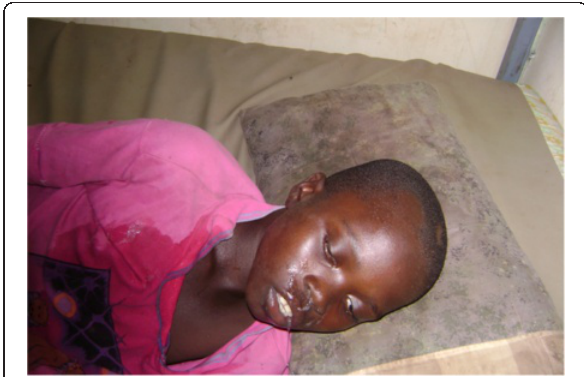
Figure 4 Associated neurotoxic and muscarinic syndromes due to Dendroaspis sp bite (note hypersalivation and profuse sweating) Photo by C. Baldé.